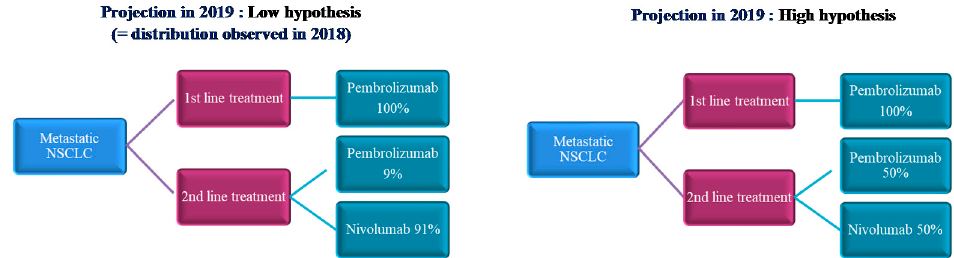
Figure 3. Illustration of the budget impact model over the time horizon.